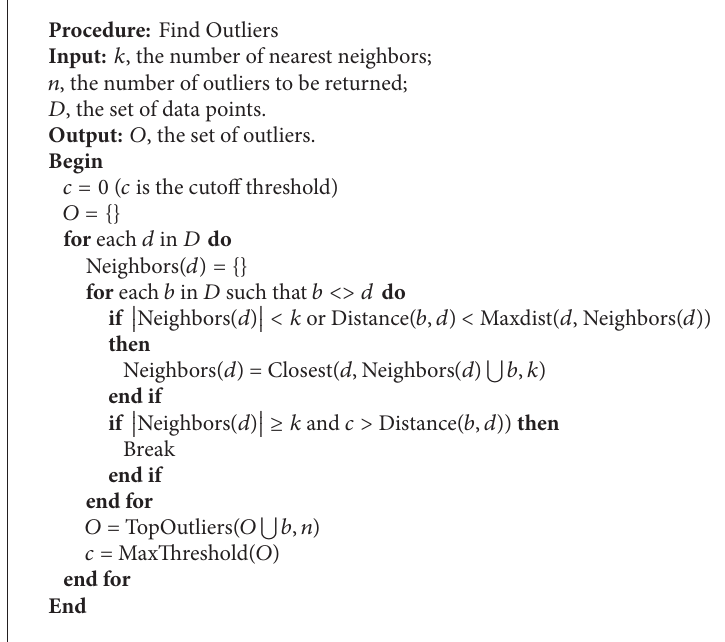
Algorithm 1: Algorithm to find outliers.